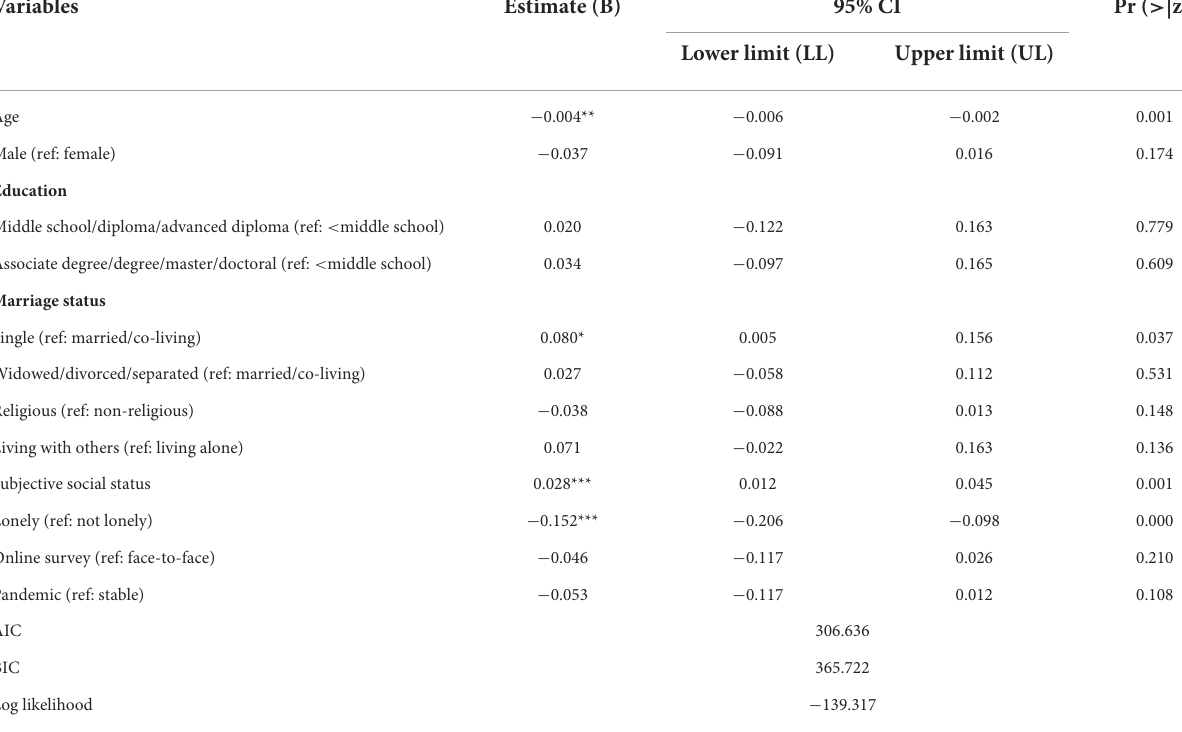
TABLE 2 Tobit regression analyses of factors associated with EQ-5D-5L HK index scores.